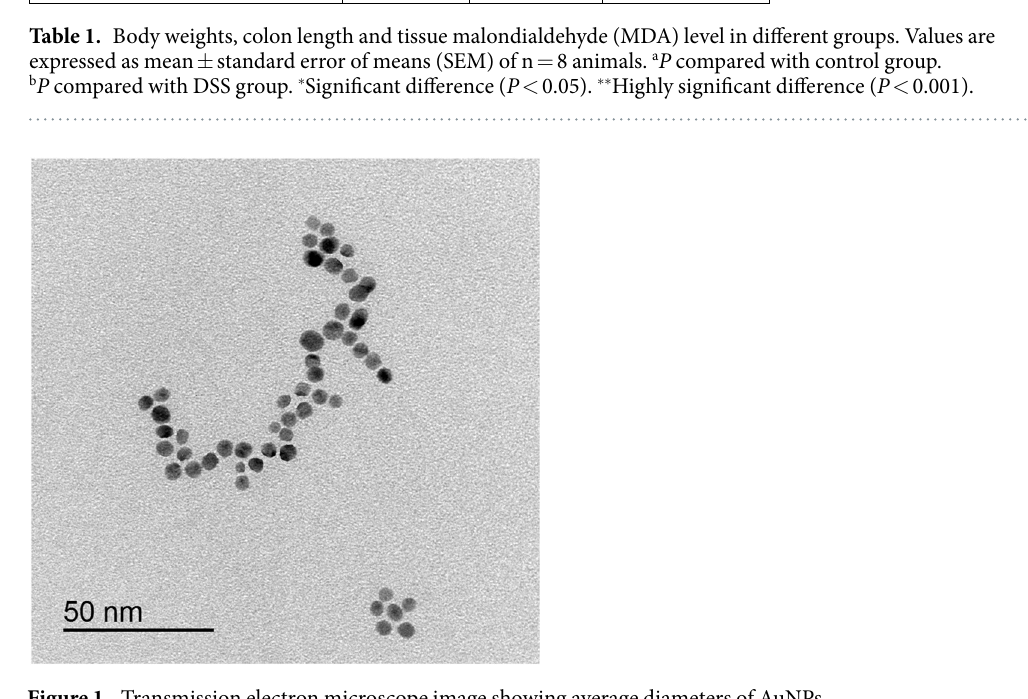
Figure 1. Transmission electron microscope image showing average diameters of